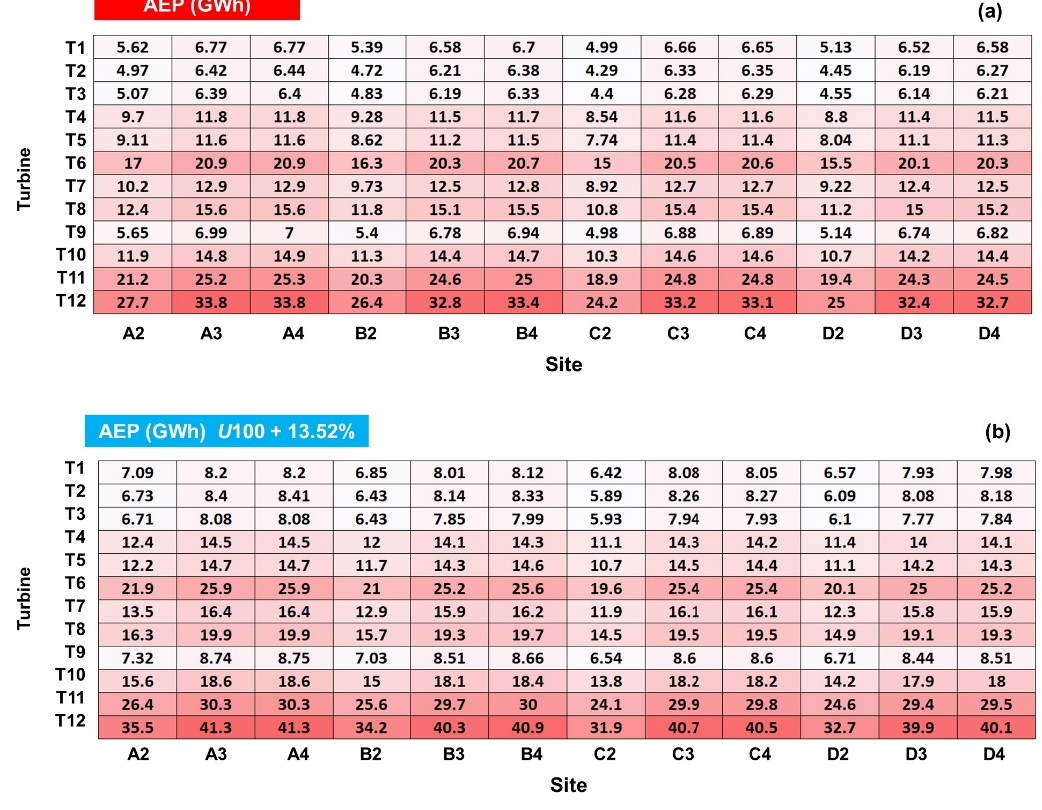
Figure 10. Annual Electricity Production (in GWh) expected to be provided by the wind turbines considered for the interval 2000–2019. Results indicated in terms of: ( a ) AEP—expected values based on ERA5 data; ( b ) adjusted AEP by considering an adjustment of the U 100 time series (each value) by 13.52%. Table 5. Top five capacity factor and AEP corresponding to the shoreline and offshore sites, excluding the points A1, B1, C1, and D1. Results available for the time interval from January 2000 until December